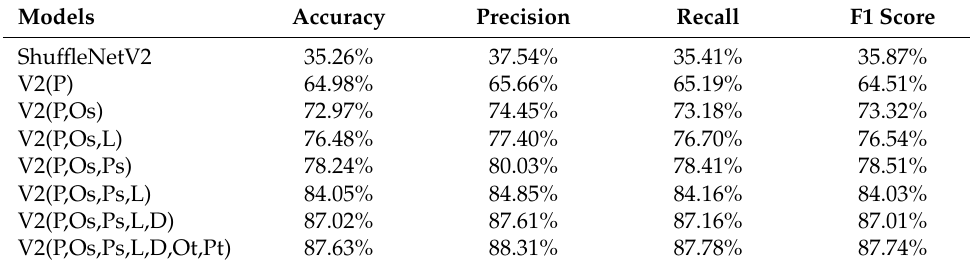
Table 1. Ablation experiments.